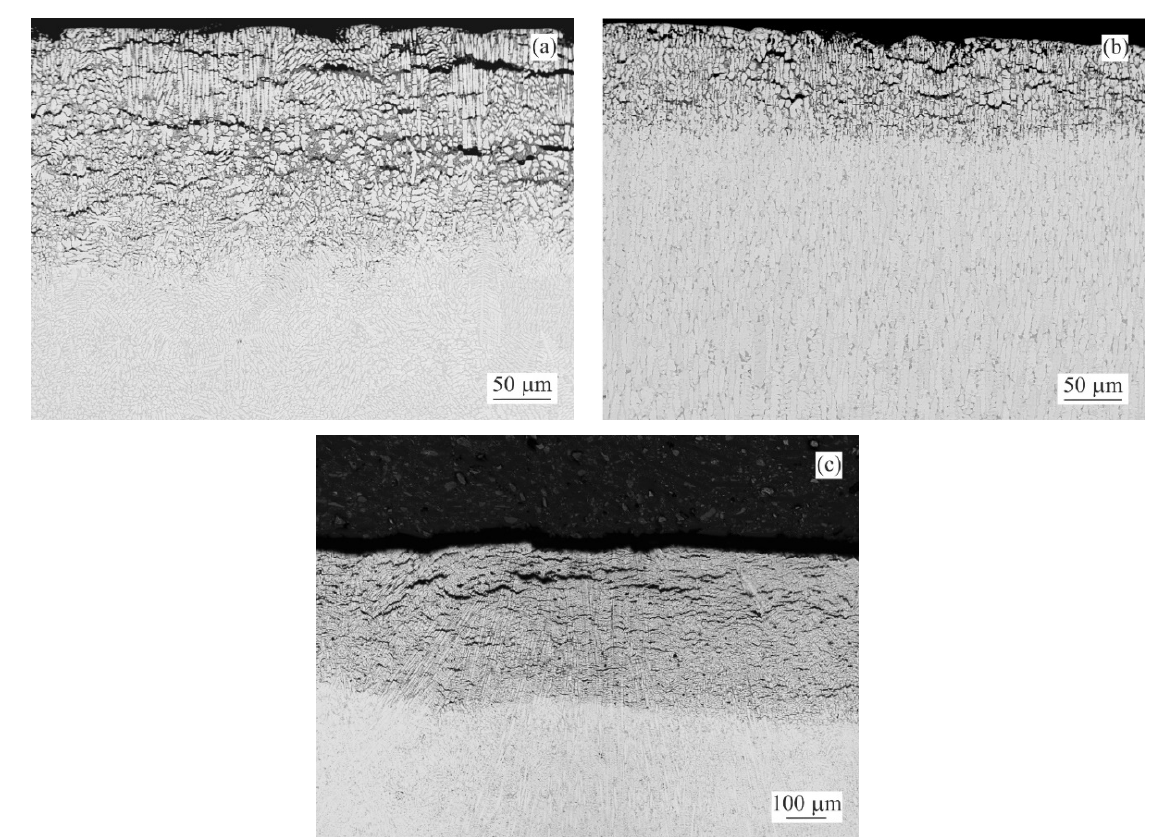
Figure 4. BSEM images indicating the extend of IG corrosion observed for the as-cast samples after 1000 h of NSST: ( a ) MZ + 0.0Sn ( b ) MZ + 0.5Sn ( c ) MZ + 3.0Sn.